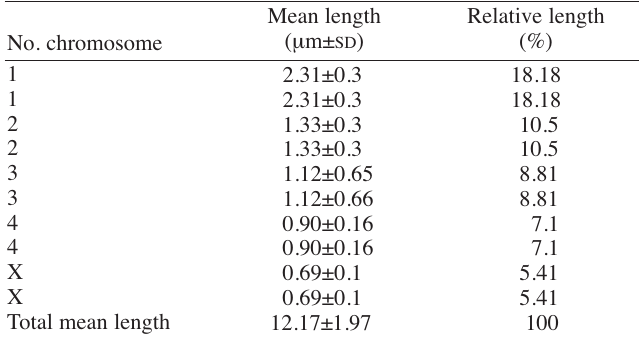
Table 2 - The mean length and relative length (%) of phylloxera chro- mosomes Mean No. chromosome